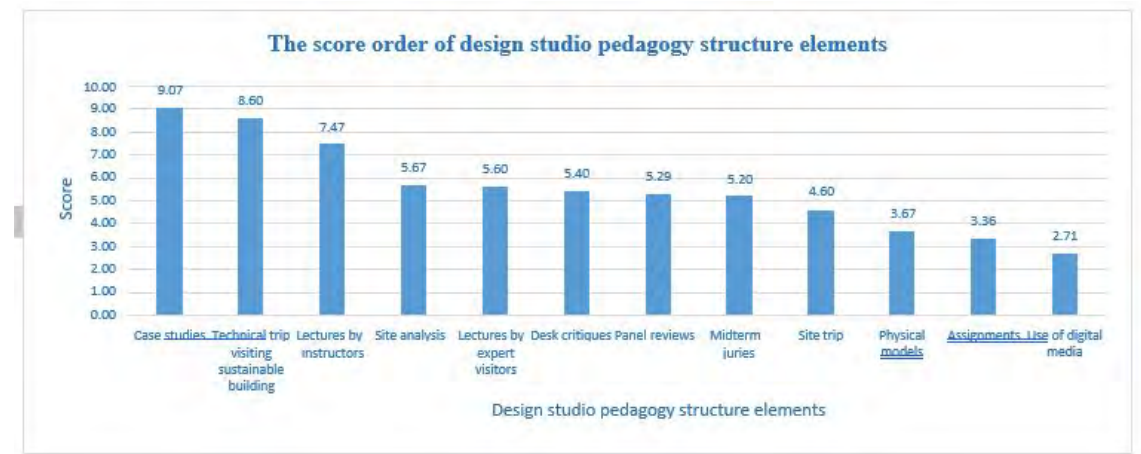
Figure 8. The case studies scored the highest points among the studio tasks